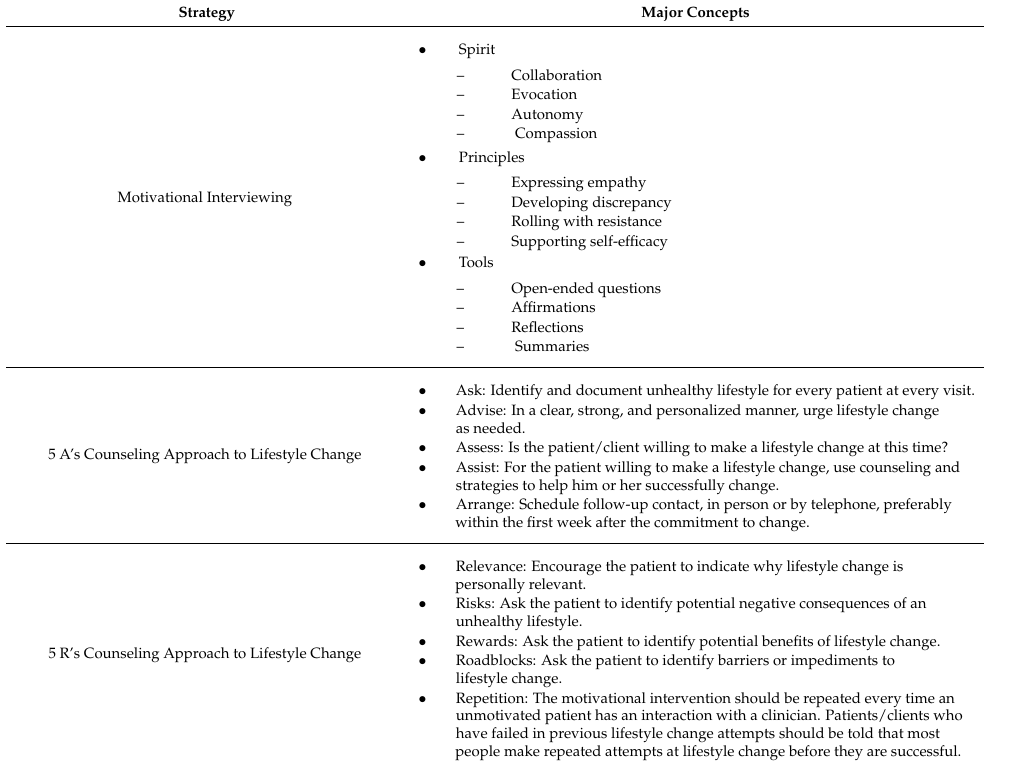
Table 4. Selected health communication